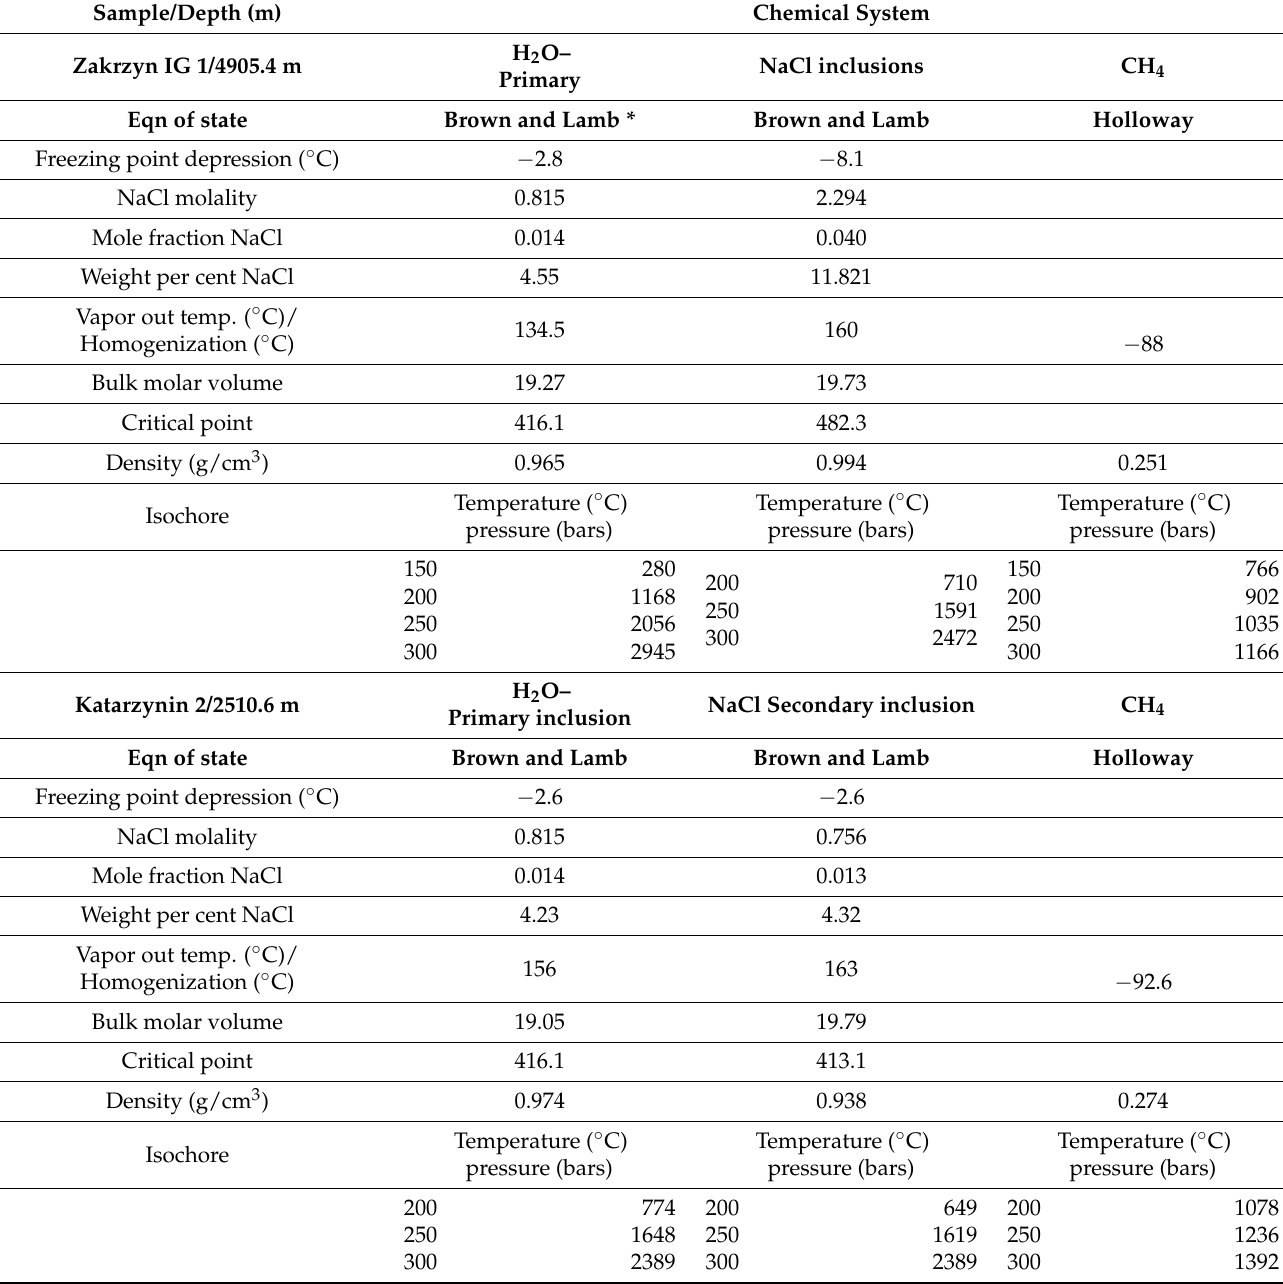
Table 8. Calculations of microthermometric results for selected groups of inclusions (based on FLINCOR [10]). Sample/Depth